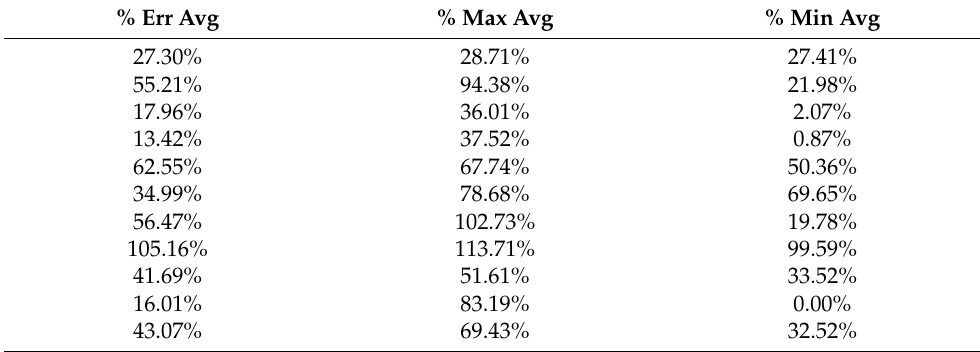
Table A149. Set 2, trials 41–50 data (single 0.5 PR value).